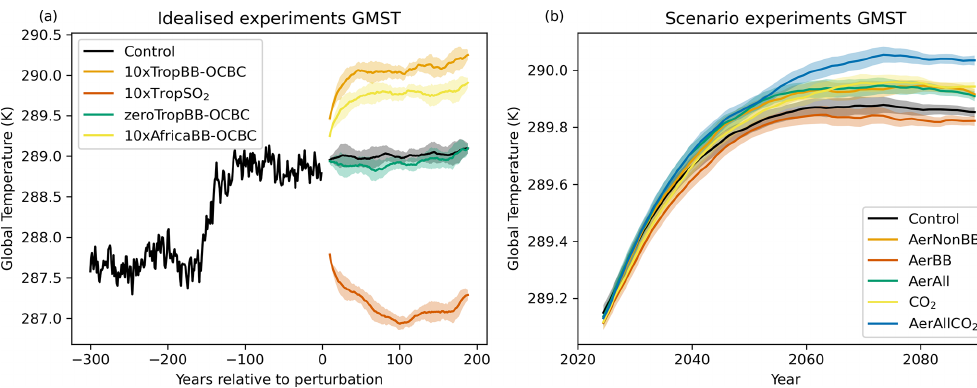
Figure 2. Global mean temperature response historically and under the idealised emissions perturbations (a) as well as through the 21st century in the emissions scenario experiments (b) . The 20-year rolling means are shown, with the control inter-member standard deviation shown by the shaded